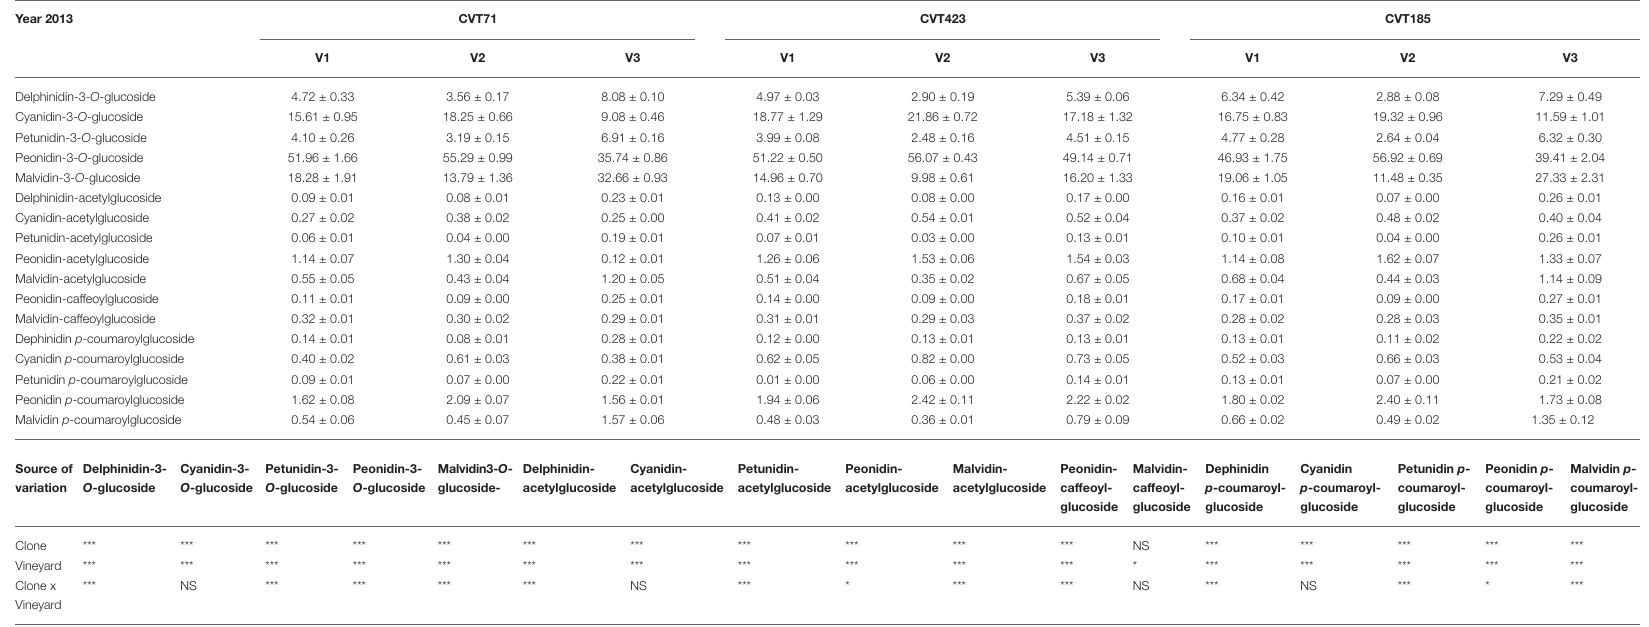
TABlE 3 | Anthocyanin profiles (percent) in the skin of grapes collected at 24°BRIX from the studied ‘Nebbiolo’ clones (CVT71, CVT423 and CVT185) in three different vineyards of the Langhe area (V1, V2, V3) in 2013. Data are means ± standard error ( n = 21 ). Results of ANOVA analysis are reported below the